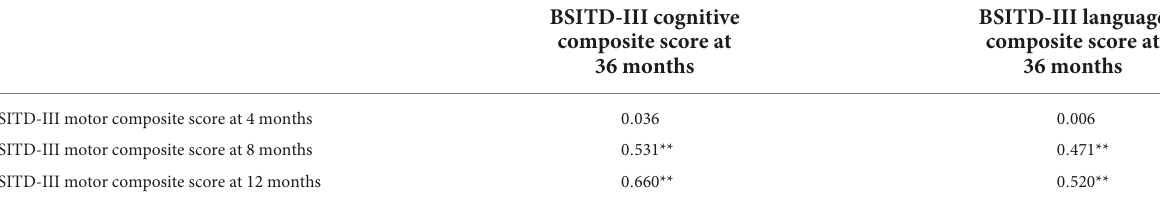
TABLE 3 Correlations of the motor outcomes at 4, 8, and 12-months with cognitive and language outcomes at 36 months.